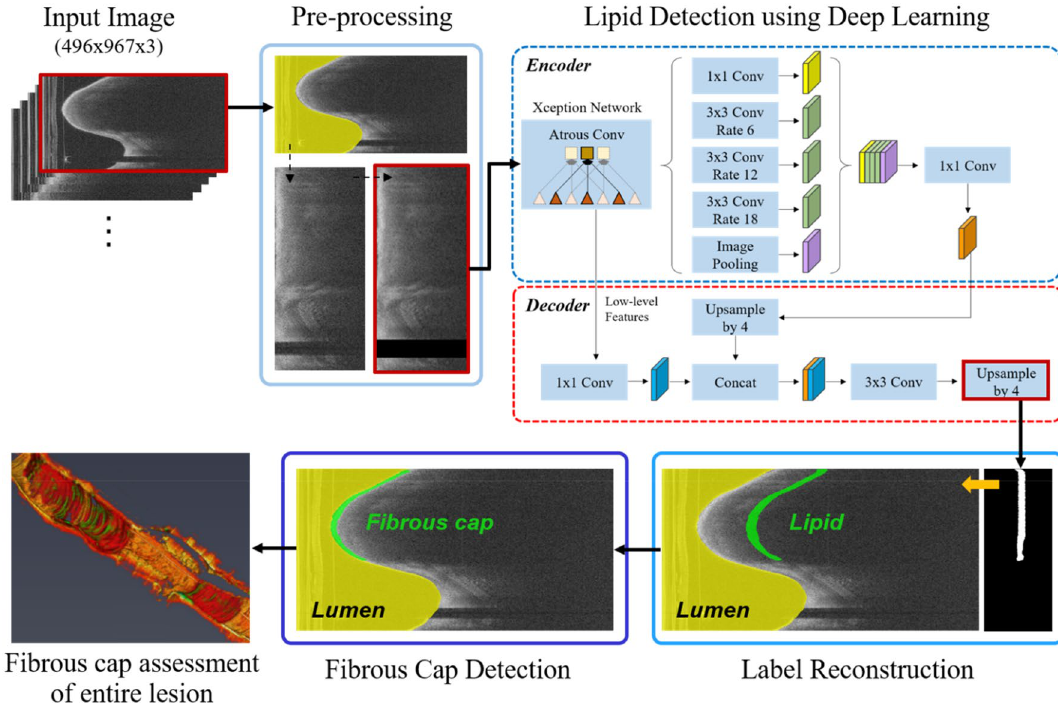
Figure 1. An overall workflow of the proposed method. Preprocessing including lumen segmentation, pixel- shifting, and noise reduction is applied to the original IVOCT ( r , θ ) image, and the output is used as an input to DeepLab-v3 plus deep learning model for lipid plaque detection. In the context of detected lipid plaque, fibrous cap is detected and quantitatively